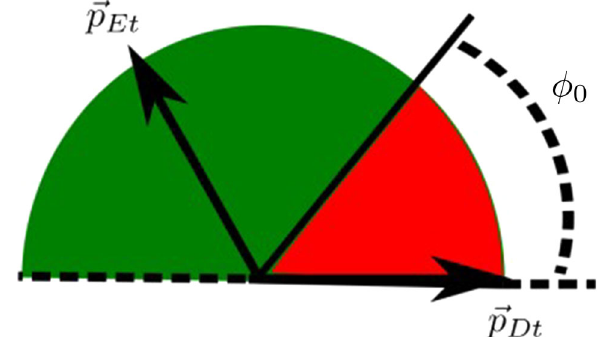
Fig. 2 Transverse momentum vector of leptons D and E, separated by an azimuthal angle φ . For a given cutoff φ 0 , the green region corre- sponds to allowed values of angles φ > φ 0 , i.e. the part of phase space which is taken into account in the calculation. The red region is cut off, therefore, the events that are closer to the back-to-back configuration are the relevant (measured)